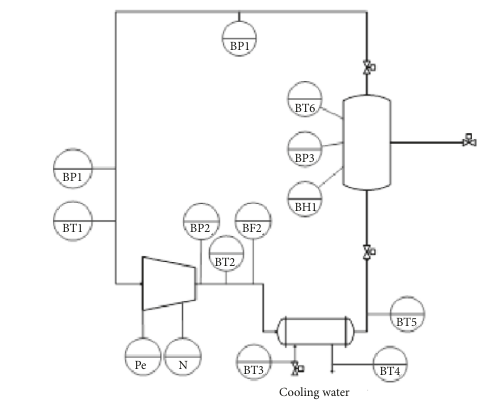
Figure 1: Process instrumentation chart. BF flow, BH humidity, N rotational speed, BP pressure, Pe electric power, and BT tempera-